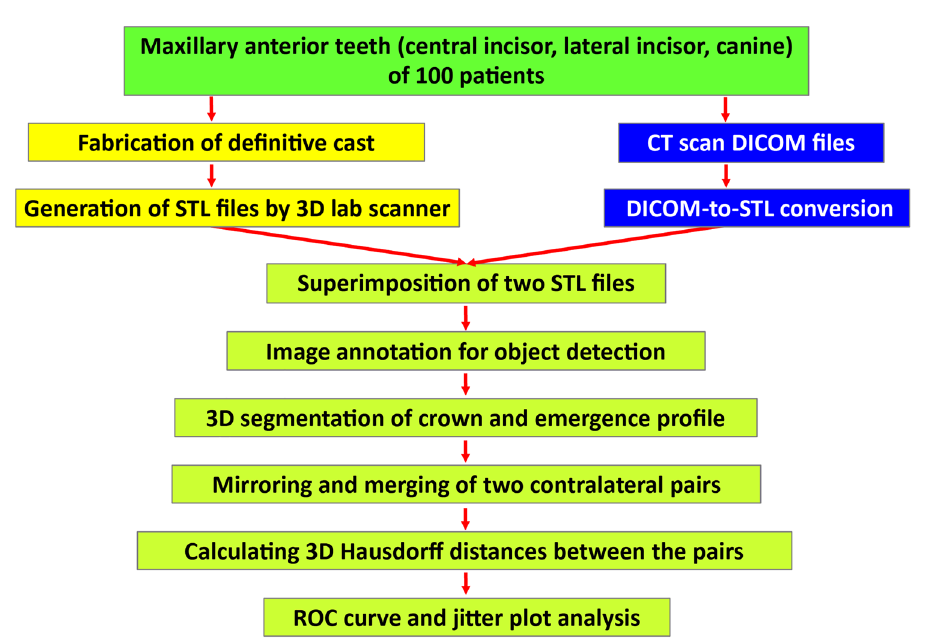
Figure 3. Summary of the workflow of the study